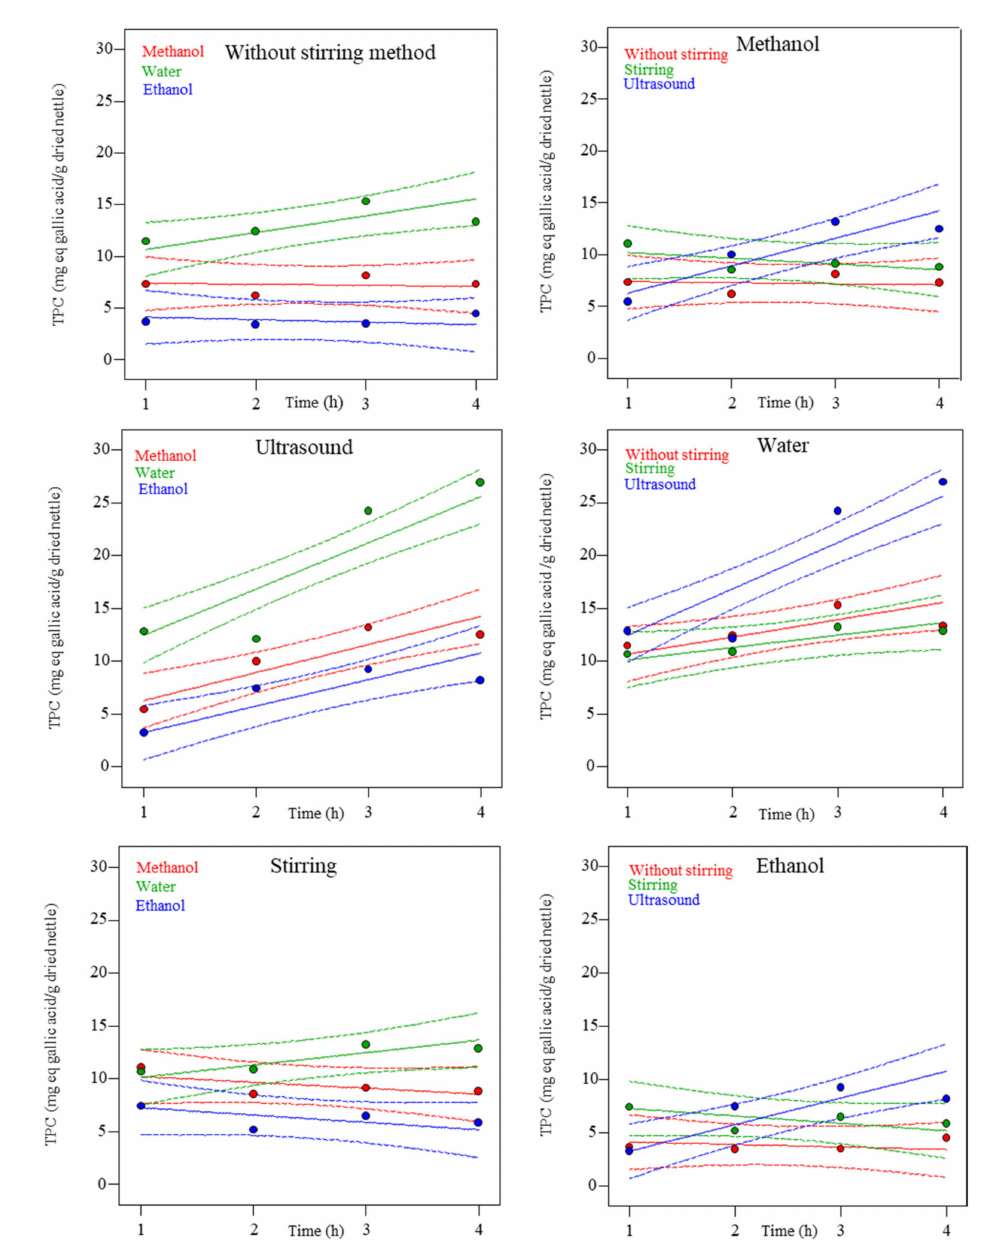
Figure 2. Experimental and predicted dependence of Total Phenolic Content (TPC) on time at different methods (without stirring, ultrasound, or stirring) and solvents (methanol, water, or ethanol). Dots are experimental results, dotted lines are 95% confidence bands, and solid lines are the predicted